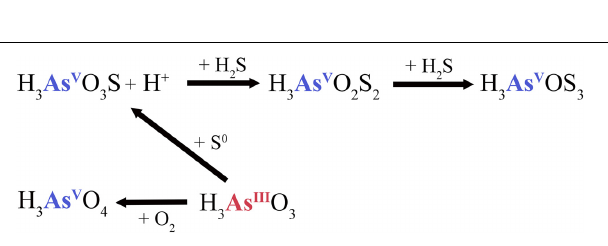
FIGURE 6 | Elemental sulfur-dependent arsenic cycle at the rim (CPr) and outflow channel (CPc) of Champagne Pool. H 3 AsO 3 S, monothioarsenate; H 3 AsO 2 S 2 , dithioarsenate; H 3 AsOS 3 , trithioarsenate.